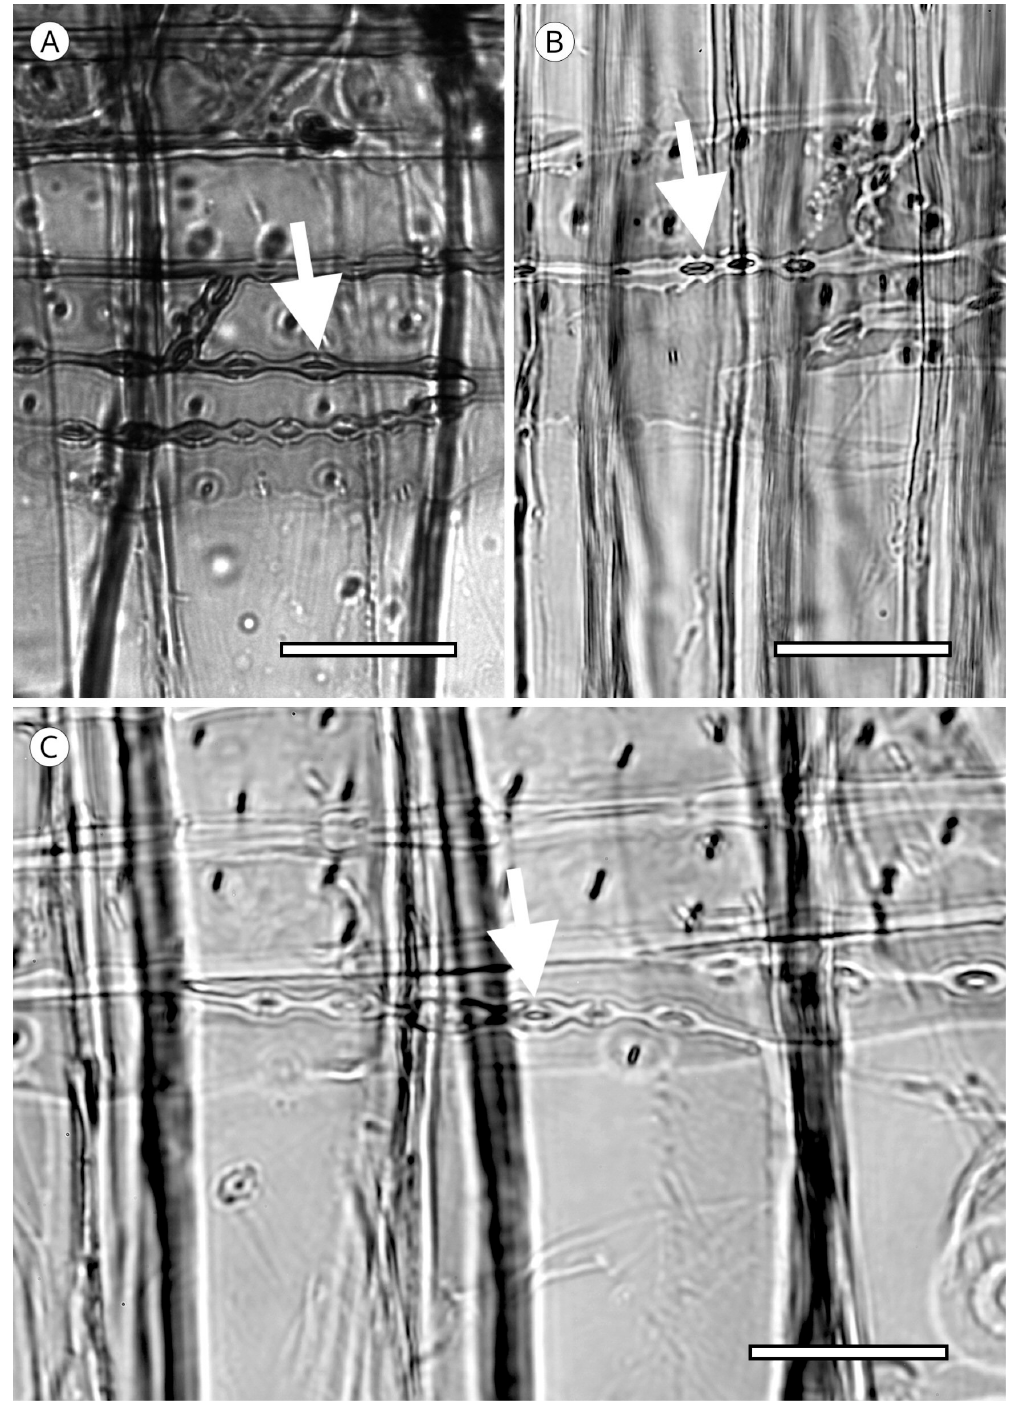
Figure 31. Pit borders of ray tracheids. ( A ) Pit apertures narrow in Picea alcoquiana (H.J.Veitch ex Lindl.) Carrière; ( B ) Pit borders with dentate thickenings in Picea abies (L.) H.Karst.; ( C ) Pits with wide apertures in Larix laricina (Du Roi) K.Koch. Scale bars. ( A – C ) = 25 μ m.